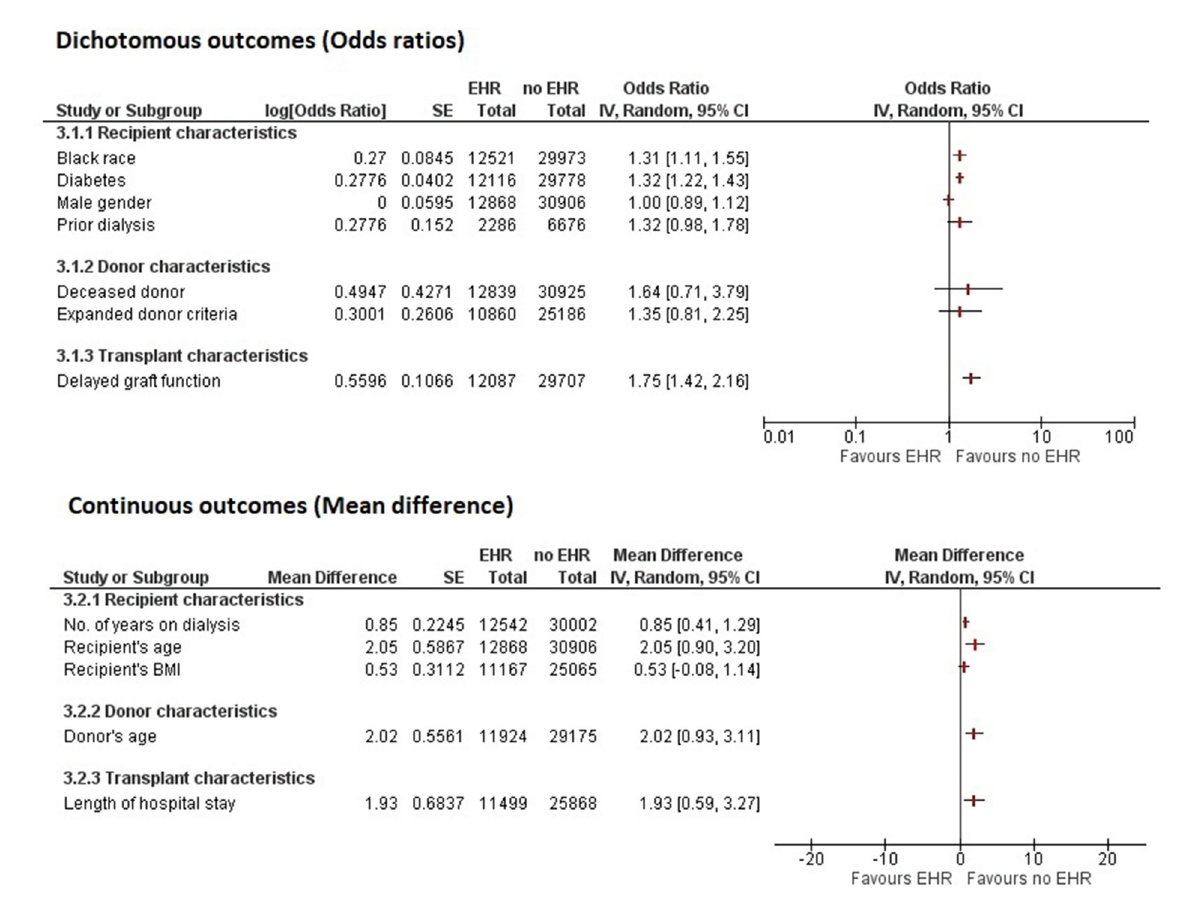
FIGURE1 Forest plot summarizing the pooled analyses of all potential factors associated with early hospital readmission (30-day) after kidney transplantation. IV, inverse variance; SE, standard error; CI, confidence interval; HER, early hospital readmission.